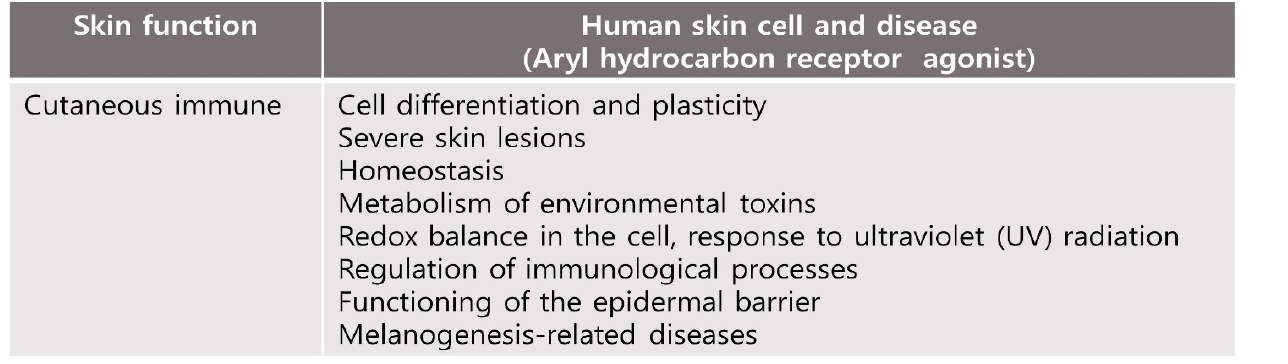
Figure 2. Effects of human skin cell and disease by TCDD (an AhR agonist) exposure and activation of AhR. AhR plays an important role in maintaining skin homeostasis in human skin.